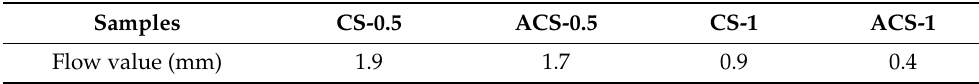
Table 7. Flow value of